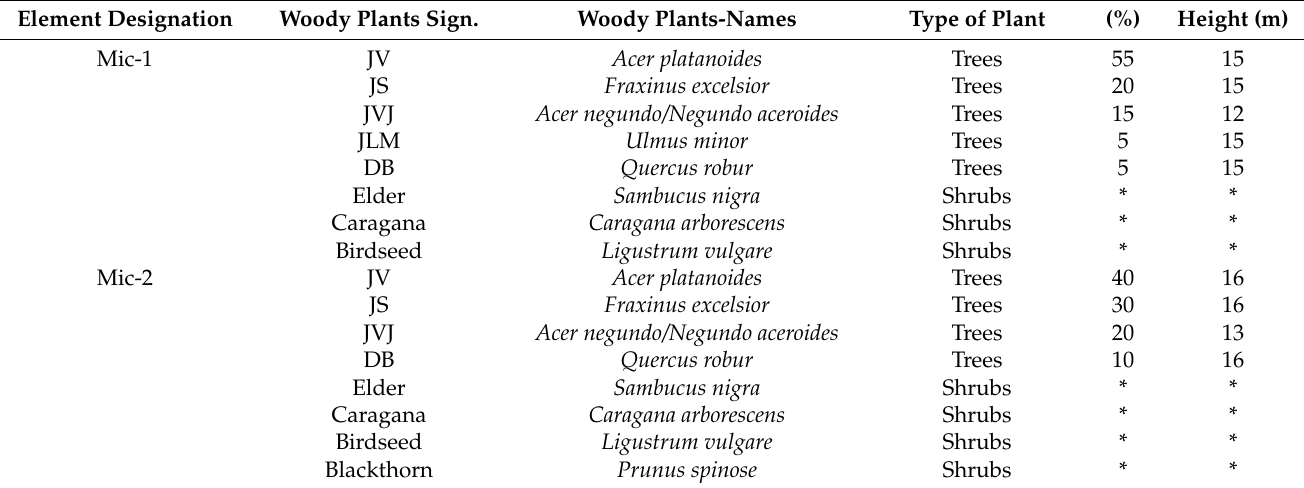
Table 8. Example of evaluation of two windbreaks in study locality Micmanice.